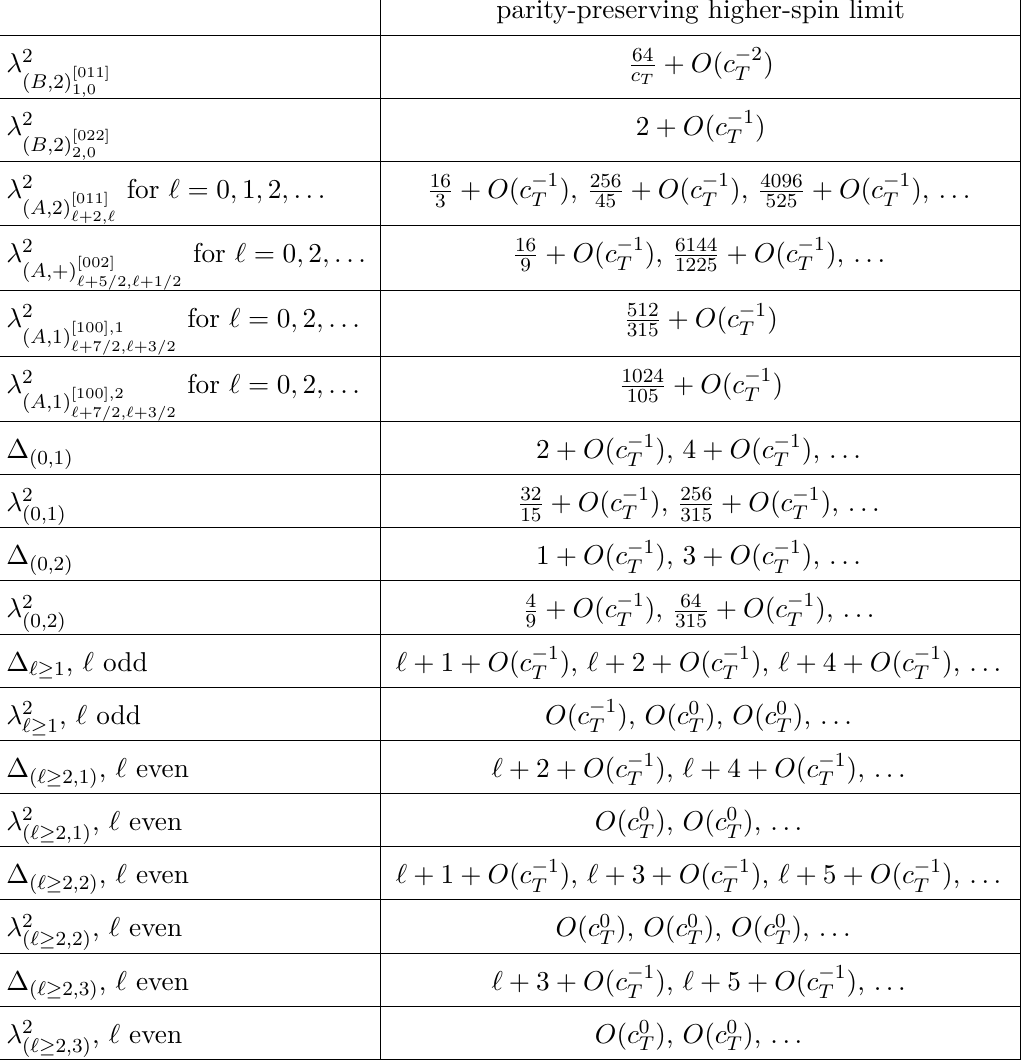
Table 12 . Low-lying single and double trace CFT data for a parity-preserving N = 6 SCFT such as the U(1) 2 M × U(1+ M ) − 2 M theory in the higher-spin limit. We write ∆ the scaling dimensions and OPE coefficients squared, respectively, of the superblock corresponding to the structure Long [000] ,n ∆